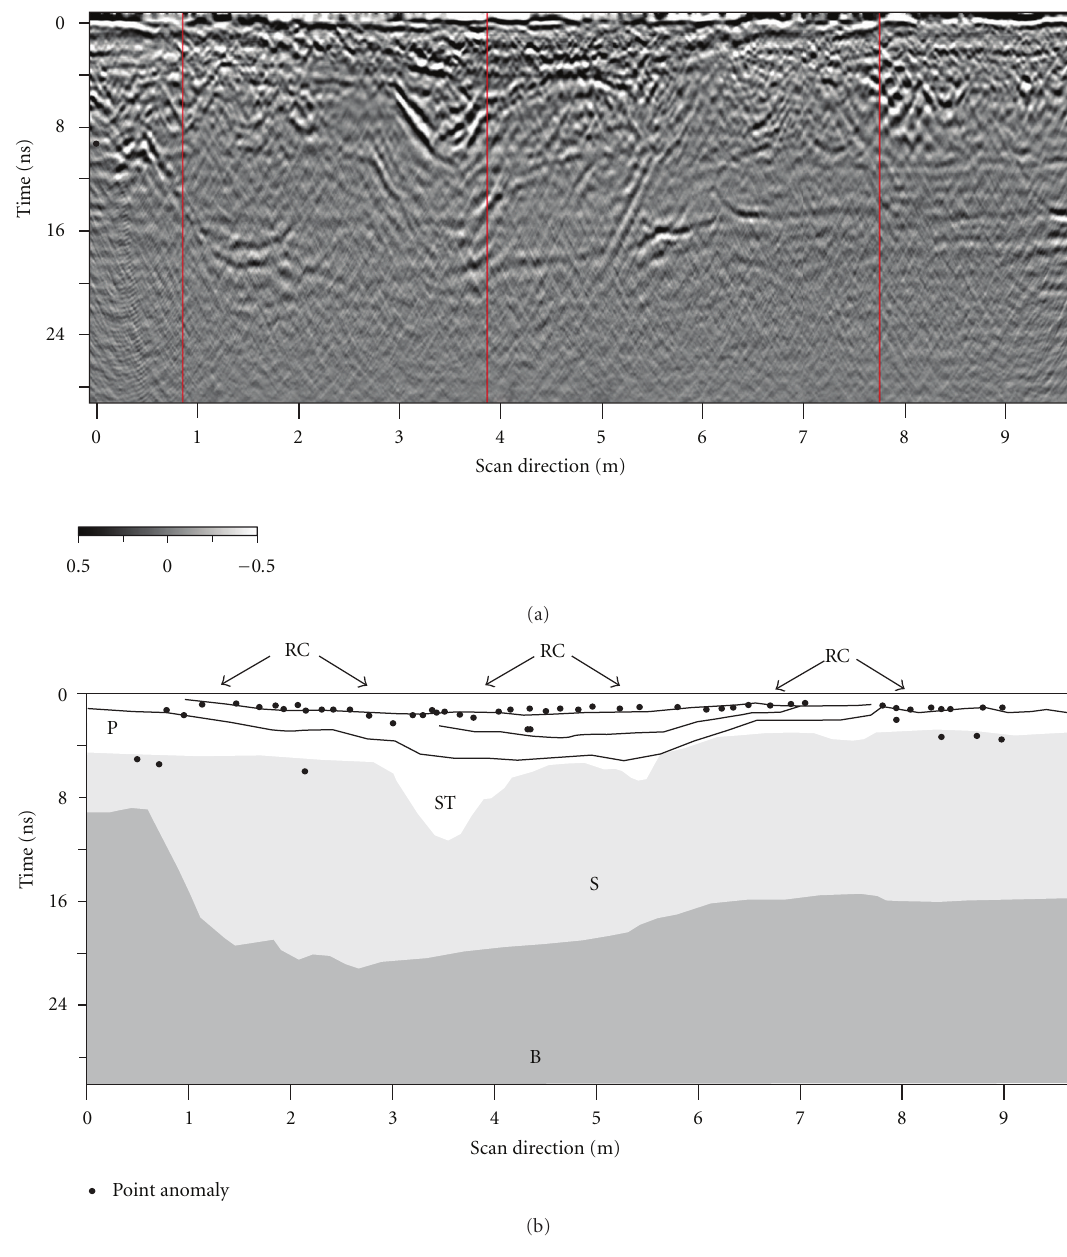
Figure 6: Damaged road section due to pavement settlement (ST) and ramified cracks (RC). 1600MHz migrated radar section (a) and its line drawing (b); di ff erent road layers (P: pavement; S: subgrade; B: bedrock) are drawn; the corresponding power diagram is reported in Figure